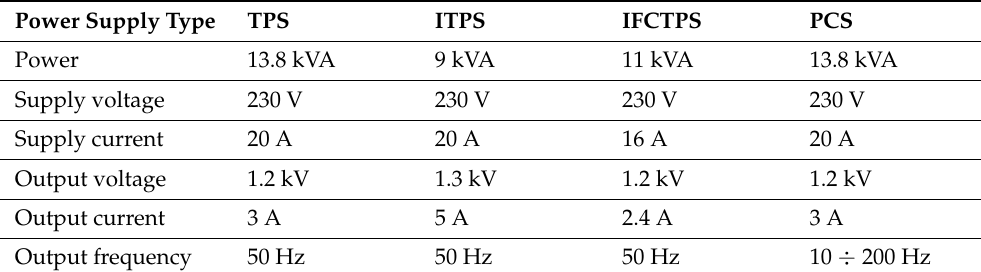
Figure 2. Transformer power system TPS, PR — plasma reactor, T — reactor working electrodes power circuit, IS — ignition electrodes power circuit, N P1 , N P2 , N P3 — primary windings, N S1 , N S2 , N S3 — secondary windings, WE 1 , WE 2 , WE 3 — plasma reactor working electrodes, IE 1 , IE 2 — reactor ignition electrodes. Table 2. Parameters of the reactor working electrode supply circuits.